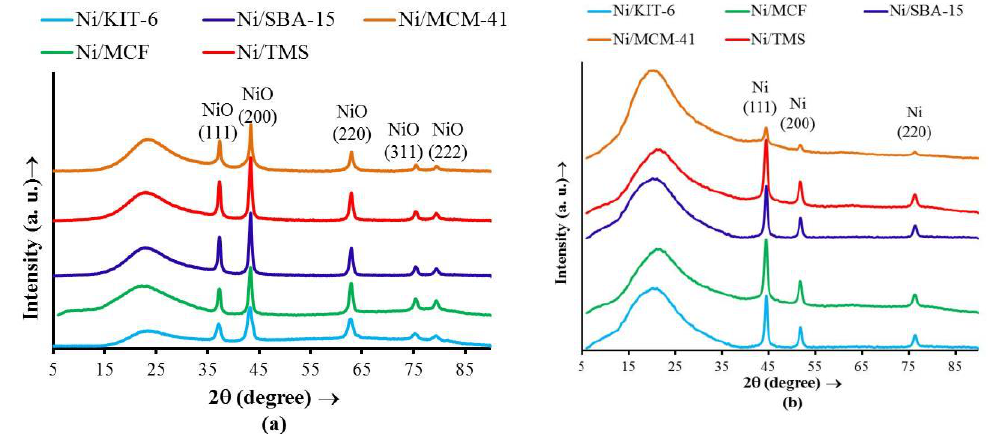
Figure 4. X-ray patterns of ( a ) calcined and ( b ) reduced Ni/SiO 2 catalysts.